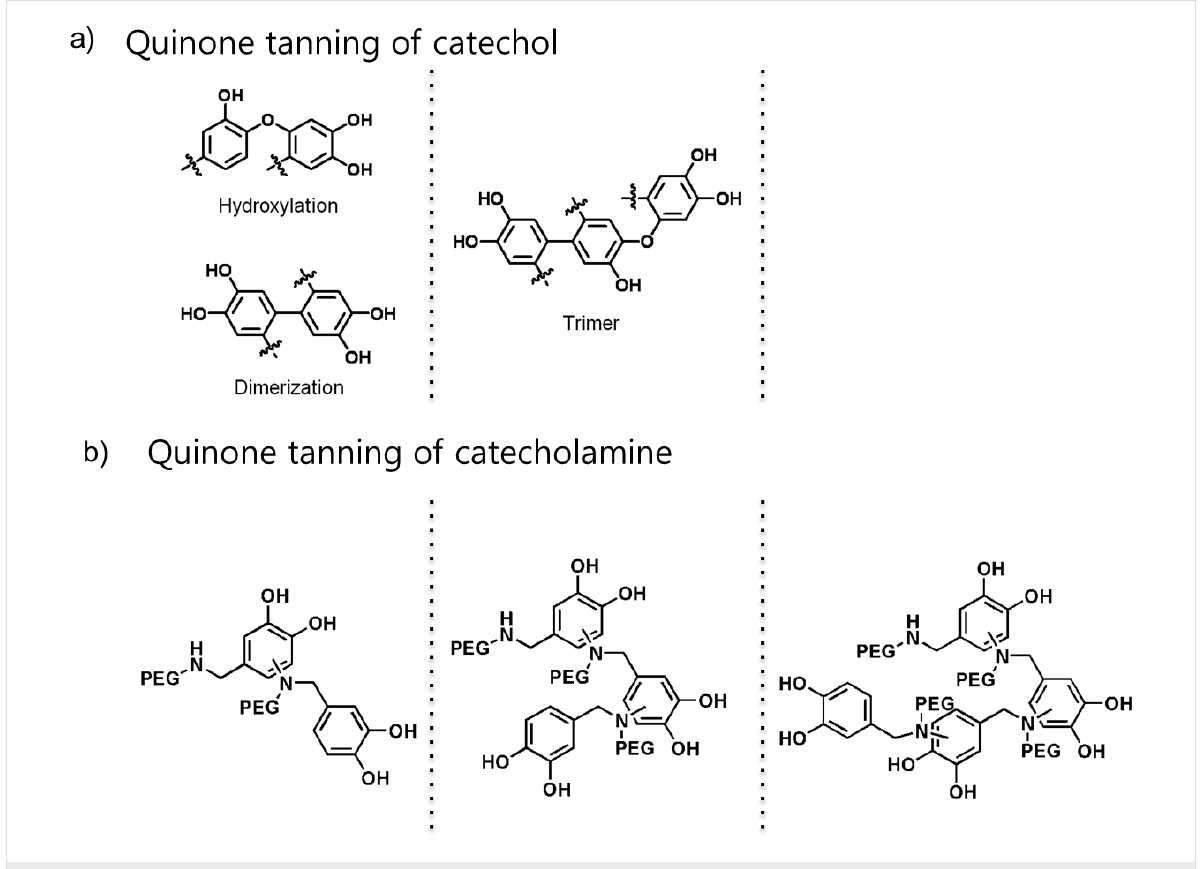
Figure 4: Proposed chemical structures of crosslinked products by quinone tanning reactions. (a) Catechol quinone tanning and (b) catecholamine quinone tanning. In catecholamine tanning, amine-involved crosslinking shown in (b) is more favorable than catechol tanning pathway shown in (a).